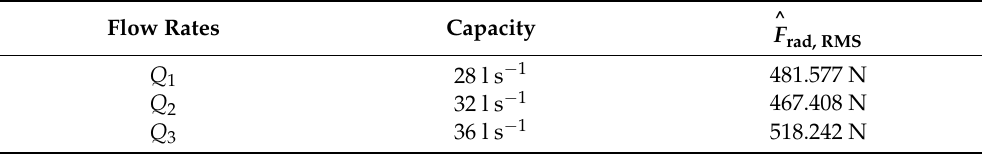
Figure 5. Radial force fluctuation during six revolutions of the impeller for flow rates Q 1 , Q 2 and